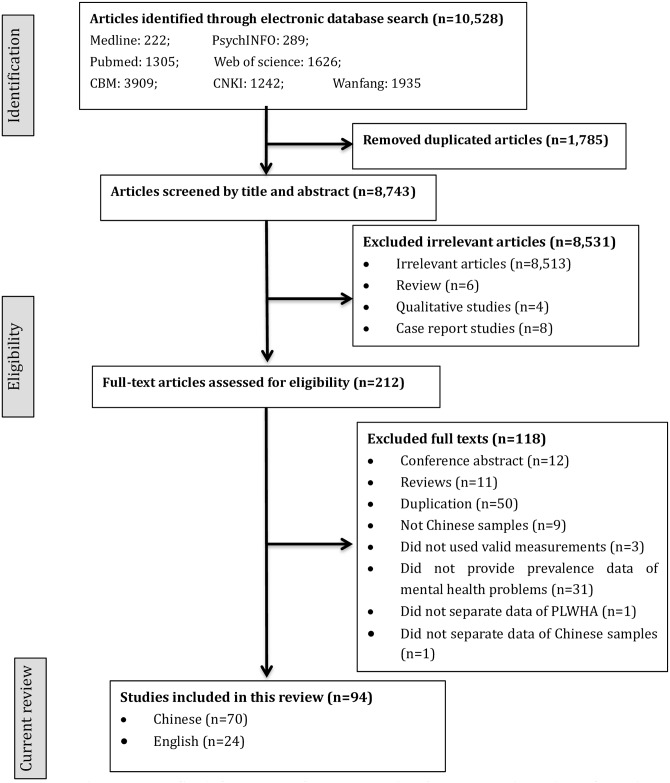
PRISMA flowchart of study selection for systematic review of published research on prevalence of mental health problems among people living with HIV.